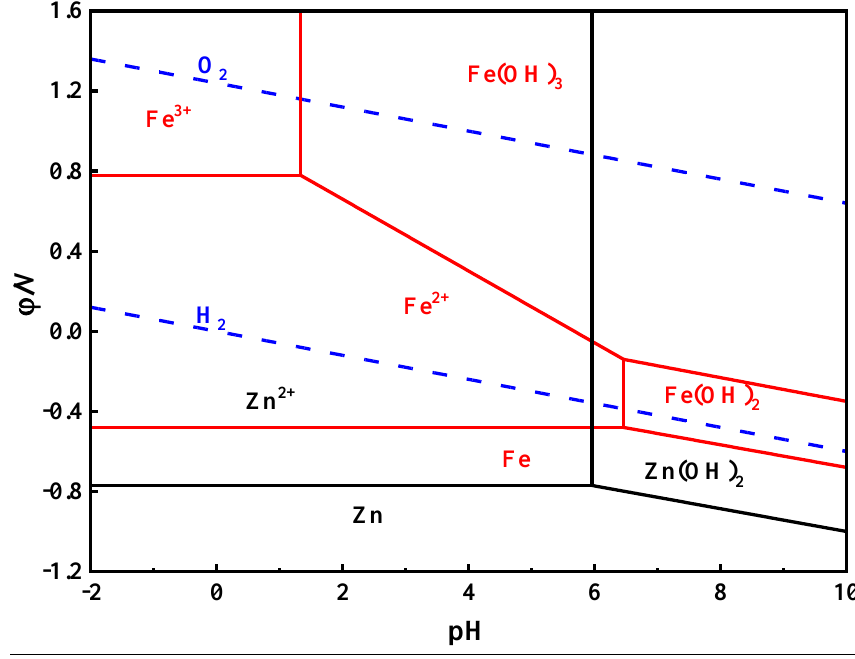
Figure 6. ϕ − pH diagram for Zn − Fe − H2O system at 25 ◦ C (aMen+ = 0.01, 25 ◦ C, 1.0 bar). Figure 6. φ − pH diagram for Zn − Fe − H Figure 6. φ − pH diagram for Zn − Fe − H 2 O system at 25 °C (a Men+ = 0.01, 25 °C, 1.0 bar) . 2 O system at 25 °C (a Men+ = 0.01, 25 °C, 1.0 bar) .